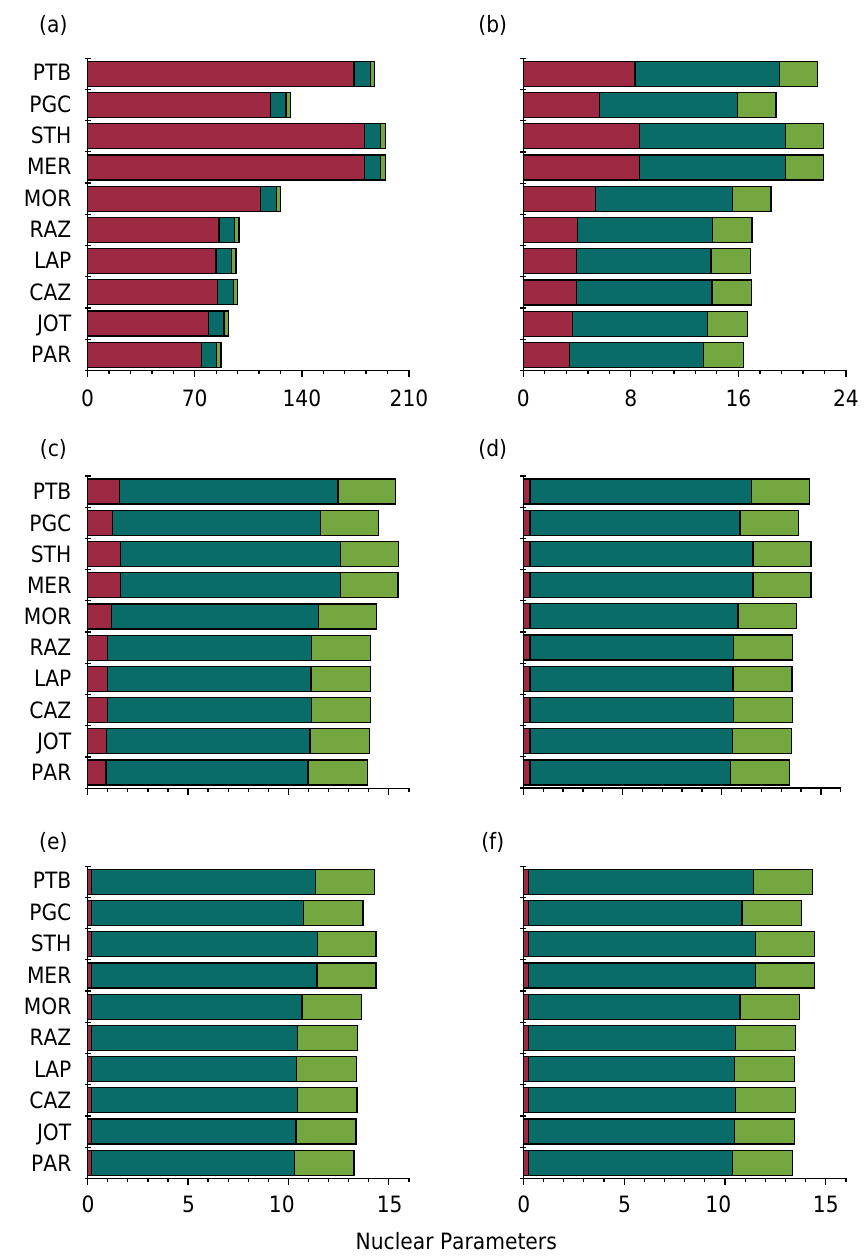
Figure 5. Variation of the electron density, effective atomic number, and electronic cross-section with photon energy. N el ( ), Z eff ( ), σ e ( ) at 10 keV (photon energy) (a), N el ( ), Z eff ( ), σ e ( ) at 30 keV (b), N el ( ), Z eff ( ), σ e ( ) at 59.5 keV (c), N el ( ), Z eff ( ), σ e ( ) at 356 keV (d), N el ( ), Z eff ( ), σ e ( ) at 661.6 keV (e), and N el ( ), Z eff ( ), σ e ( ) at 1330 keV (f). The acronyms utilized stand for the following municipalities: PTB (Pato Bragado), PGC (Ponta Grossa), STH (Santa Helena), MER (Mercedes), MOR (Morretes), RAZ (Rio Azul), LAP (Lapa), CAZ (Cerro Azul), JOT (Joaquim Távora), and PAR (Paranavaí). N el : electron density, Z eff : effective atomic number, σ e : electronic